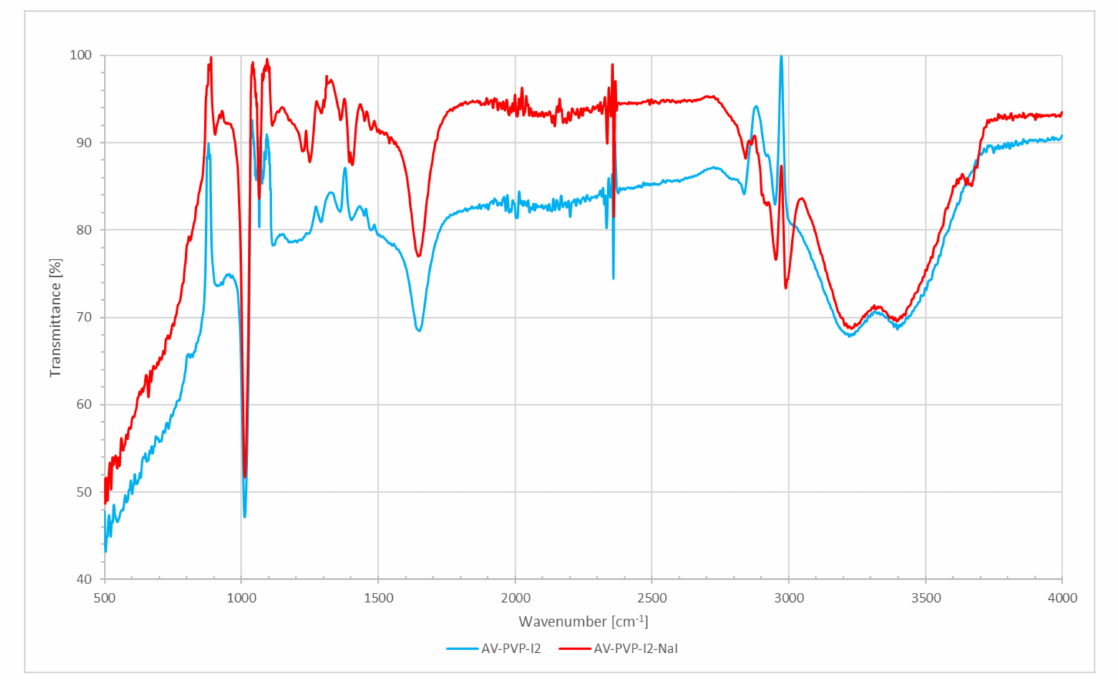
Figure 5. Fourier-transform-infrared (FT-IR) spectrometric analysis of AV-PVP-I 2 and AV-PVP-I 2